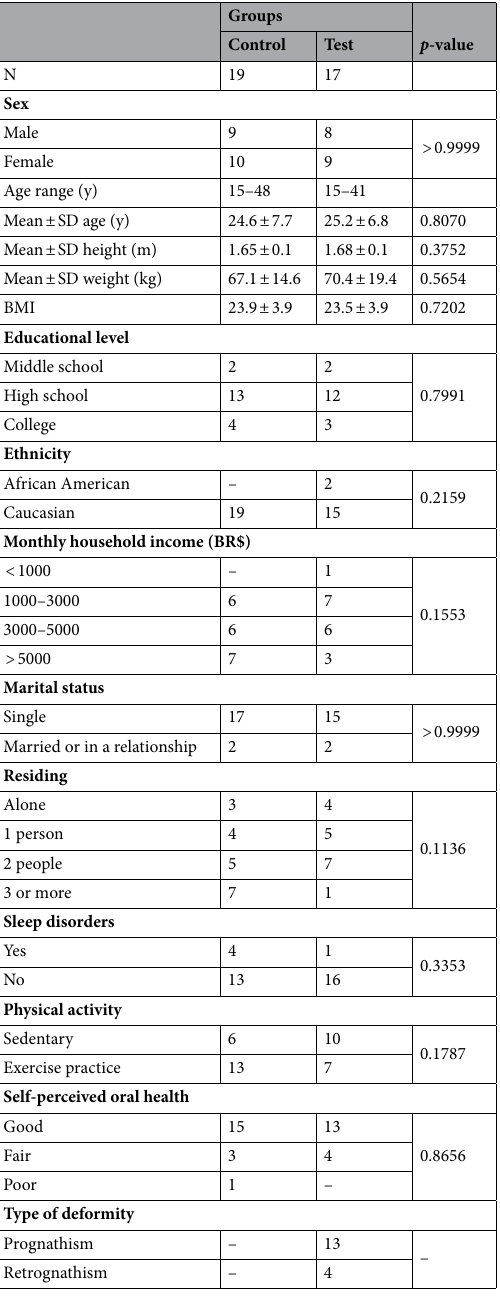
Table 1. Data regarding the socio-demographic aspects, habits, self-perceived oral health, and type of deformity. n , participants in each group; y , years; m , meter; kg , kilograms; BMI , body mass index; BRL , Brazil’s currency. Statistical analysis was performed by Unpaired Student’s t-test or chi-square test for